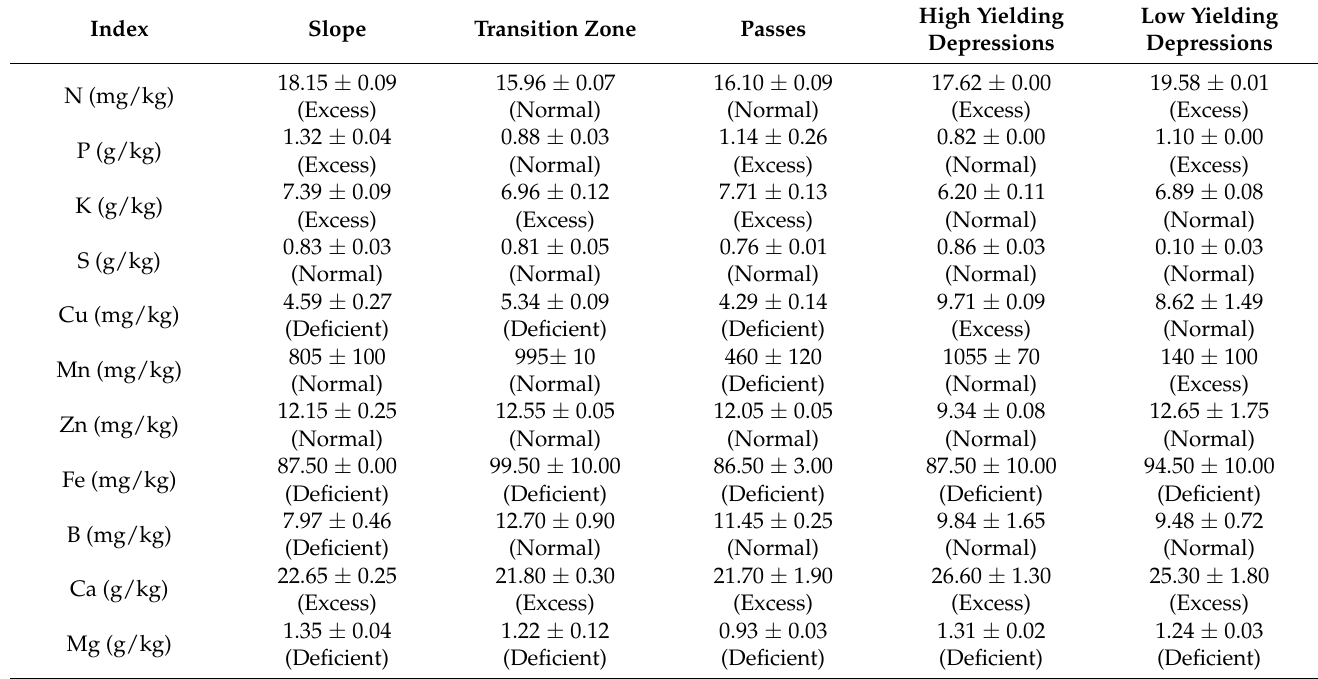
Table 2. Diagnostic results of elements in mango